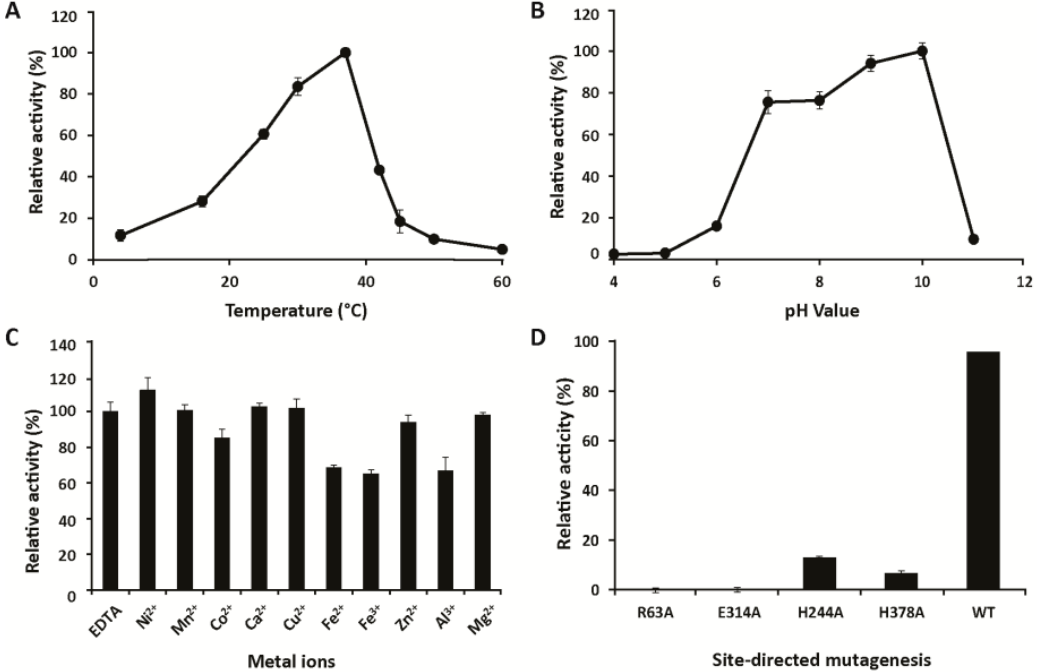
Figure 3. Biochemical characterization of PhGn2E. ( A ): Temperature dependency of recombinant PhGn2E; ( B ): pH-dependency of recombinant PhGn2E; ( C ): Impact of metal ions on the enzymatic activity of PhGn2E; ( D ): Activity study of PhGn2E active site mutants. Negative controls contained heat-inactivated wild-type (WT) PhGn2E. Data are presented as mean values ± standard deviation of three independent